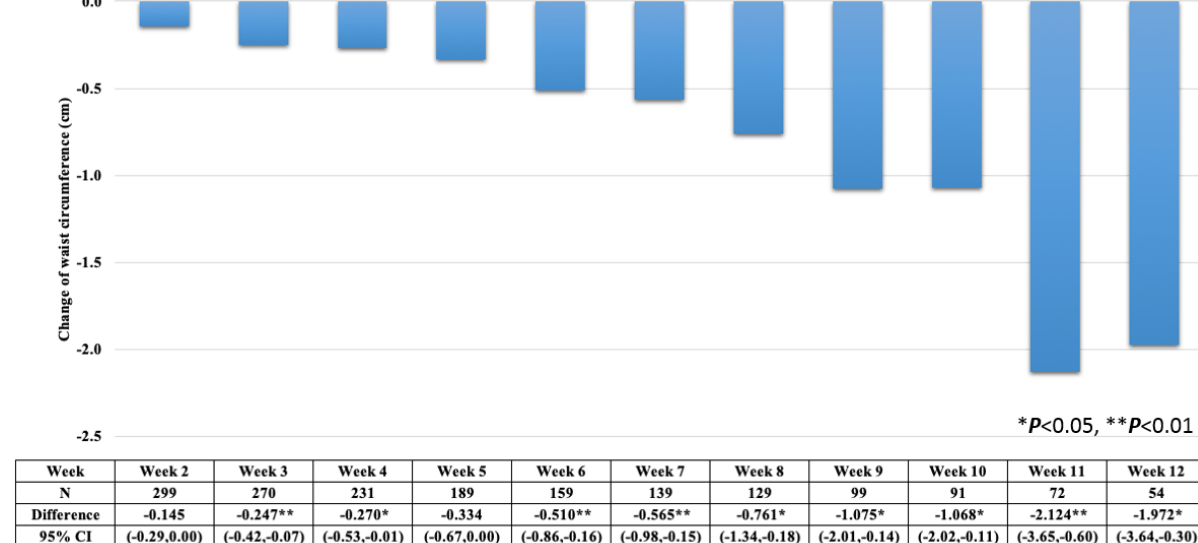
Figure 5. Reduction in waist circumferences of users each week over 12 weeks compared to baseline using paired t